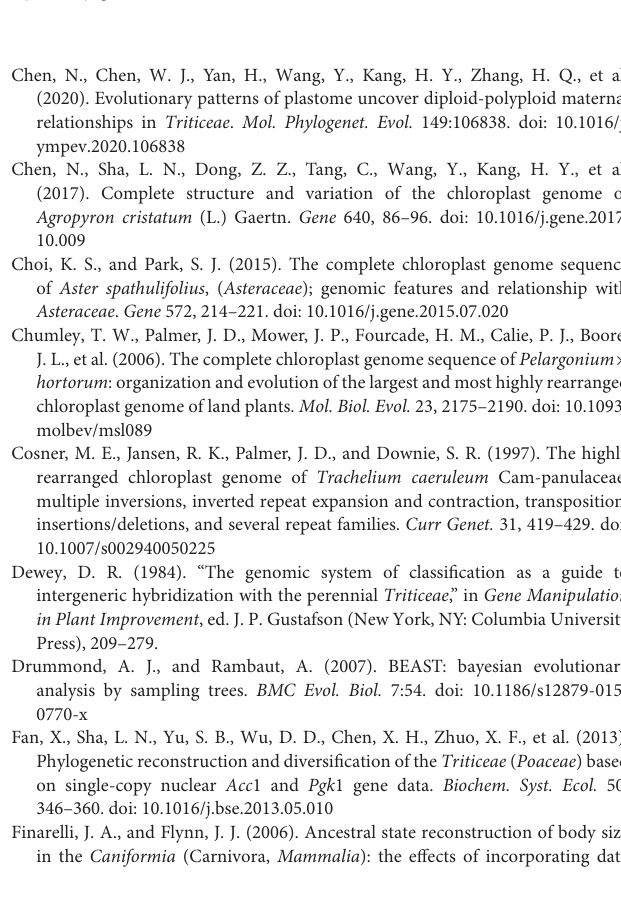
Supplementary Figure 1 | Comparison of the chloroplast genome. Alignment of the cp genome sequences of 34 Triticeae species and Brachypodium distachyon generated with mVISTA. Gray arrows indicate the position and direction of each gene. Red and blue areas indicate intergenic and genic regions, respectively. Supplementary Figures 2–17 | Indels in protein coding genes, gene loss/pseudonization, intron variation, and intergenic sequence (IGS) of 34 Triticeae diploids cp